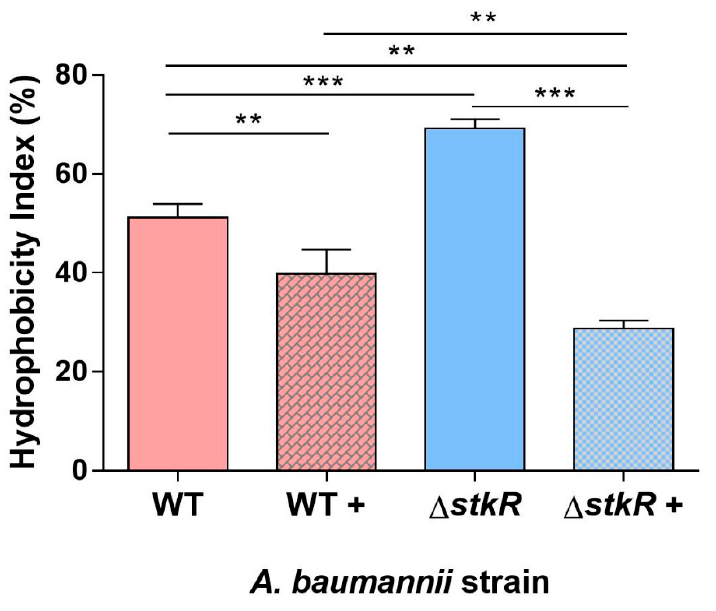
Figure 2. Cell surface hydrophobicity of A. baumannii 04117201 and ∆ stkR mutant. Cell surface hydrophobicity was assessed by the cells’ affiliation to xylene. A. baumannii strain 04117201 (WT) is without colistin exposure, WT + is with exposure to 3 µ g/mL of colistin. A. baumannii 04117201 ∆ stkR mutant is without colistin exposure, ∆ stkR + is with exposure to 3 µ g/mL of colistin. Bars represent the standard deviation of three separate experiments. A Kruskal–Wallis test was performed to compare the means of the WT and ∆ stkR mutant with and without colistin exposure. *** represents a p -value < 0.001 and ** represents a p -value of <0.01 as established by an analysis of variance test.